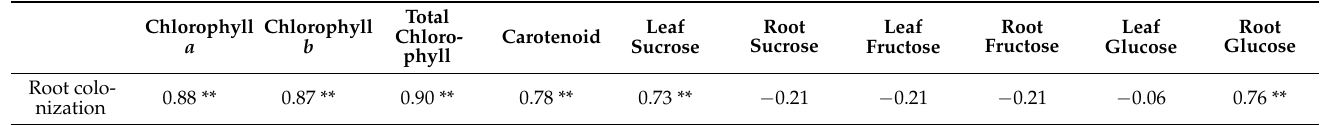
Pearson’s correlation coefficient ( r ) between root fungal colonization and plant physiological